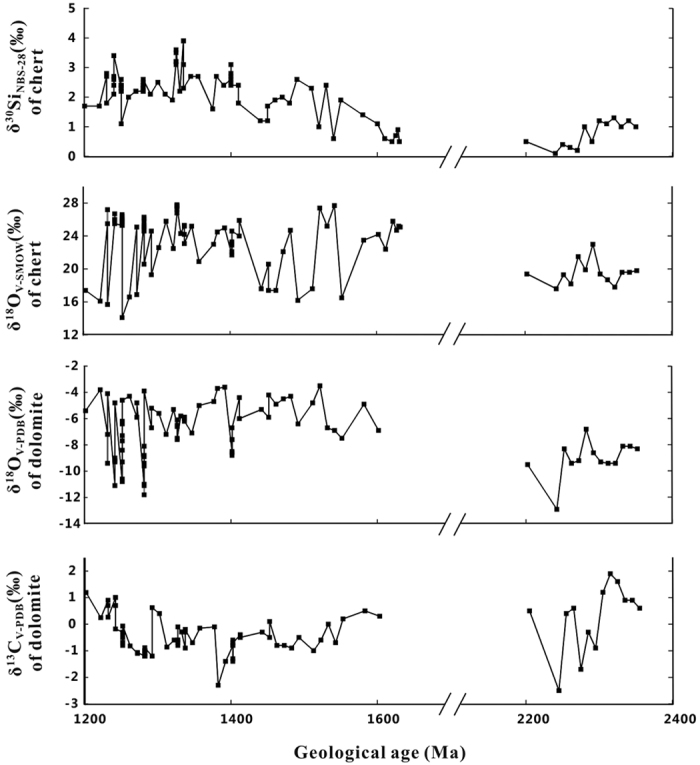
The temporal evolution of δ30SiNBS-28 and δ18OV-SMOW values of chert and δ13C V-PDB and δ18OV-PDB values of dolomite for the samples collected in this study.Analytical precisions are provided in Table 1.